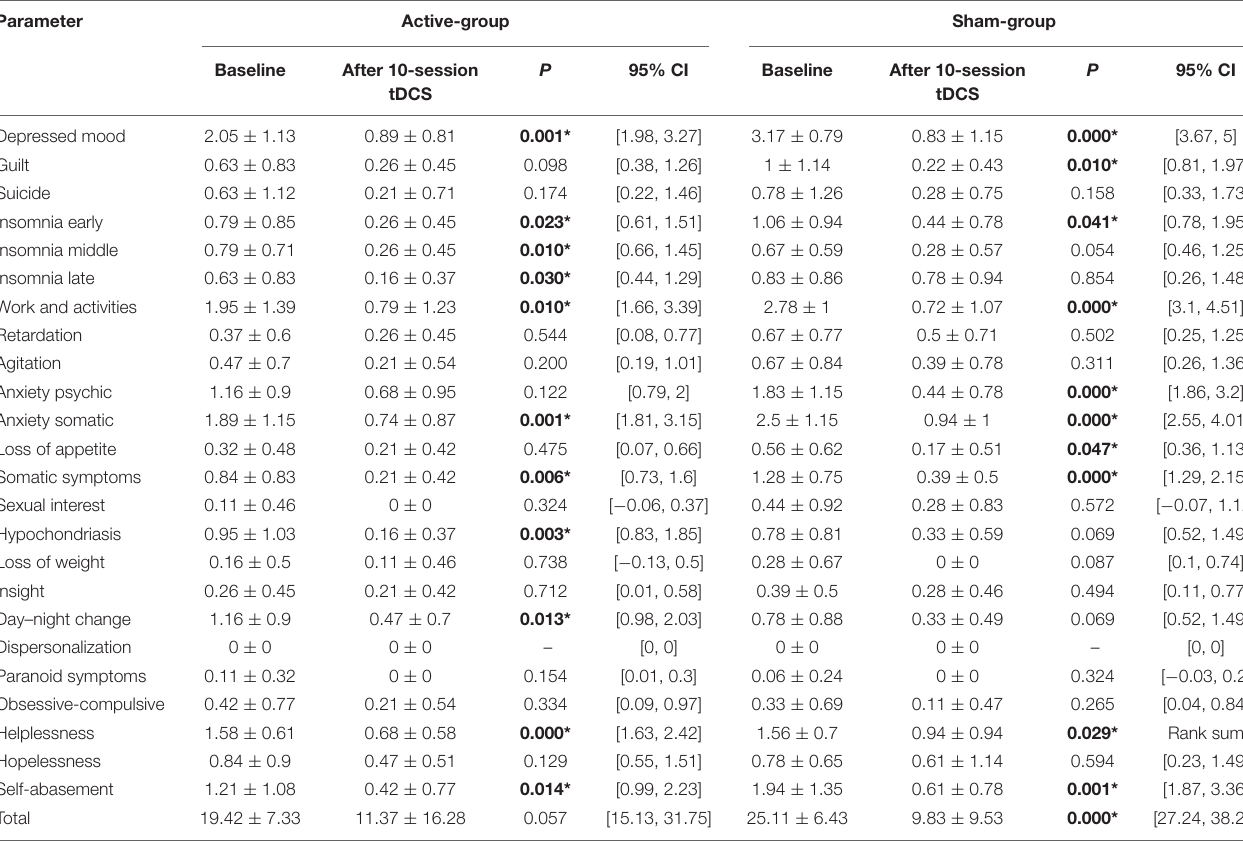
TABLE 4 | Changes in hamilton depression rating scale total score and each factor score before and after treatment in active-group and sham-group. Parameter Active-group